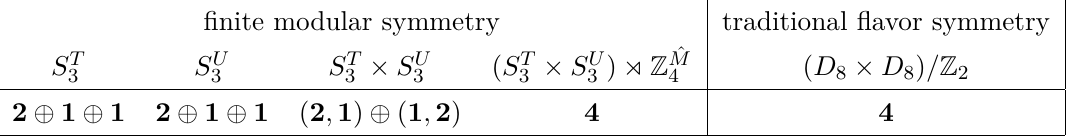
, φ , φ , φ ) T with re- (0 , 0) (1 , 0) (0 , 1) (1 , 1)